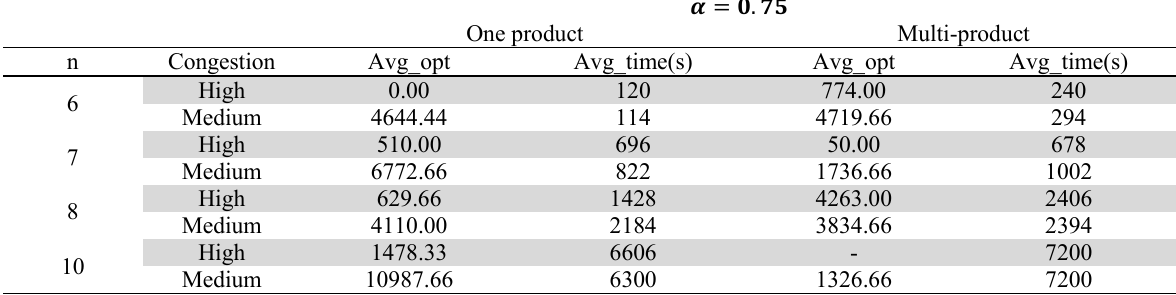
The results of the rolling horizon algorithm under low dissipation strategy (cid:2235) (cid:3404) (cid:2777). (cid:2784)(cid:2782) One product Multi-product